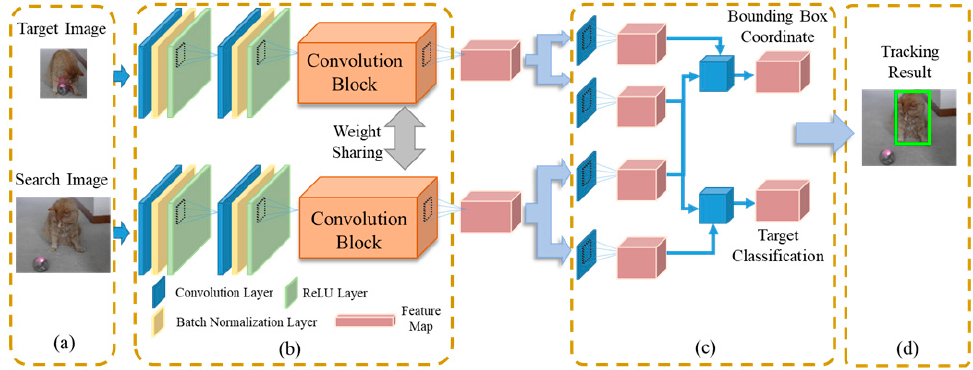
Figure 2. Proposed Tracking Algorithm with Siamese Network: ( a ) Target image and search region, ( b ) Siamese network consisting of convolution blocks used in feature extraction and highlighting the region of interest, ( c ) RPN for object region and bounding box coordinate prediction, ( d ) Tracking result marked by the green box.